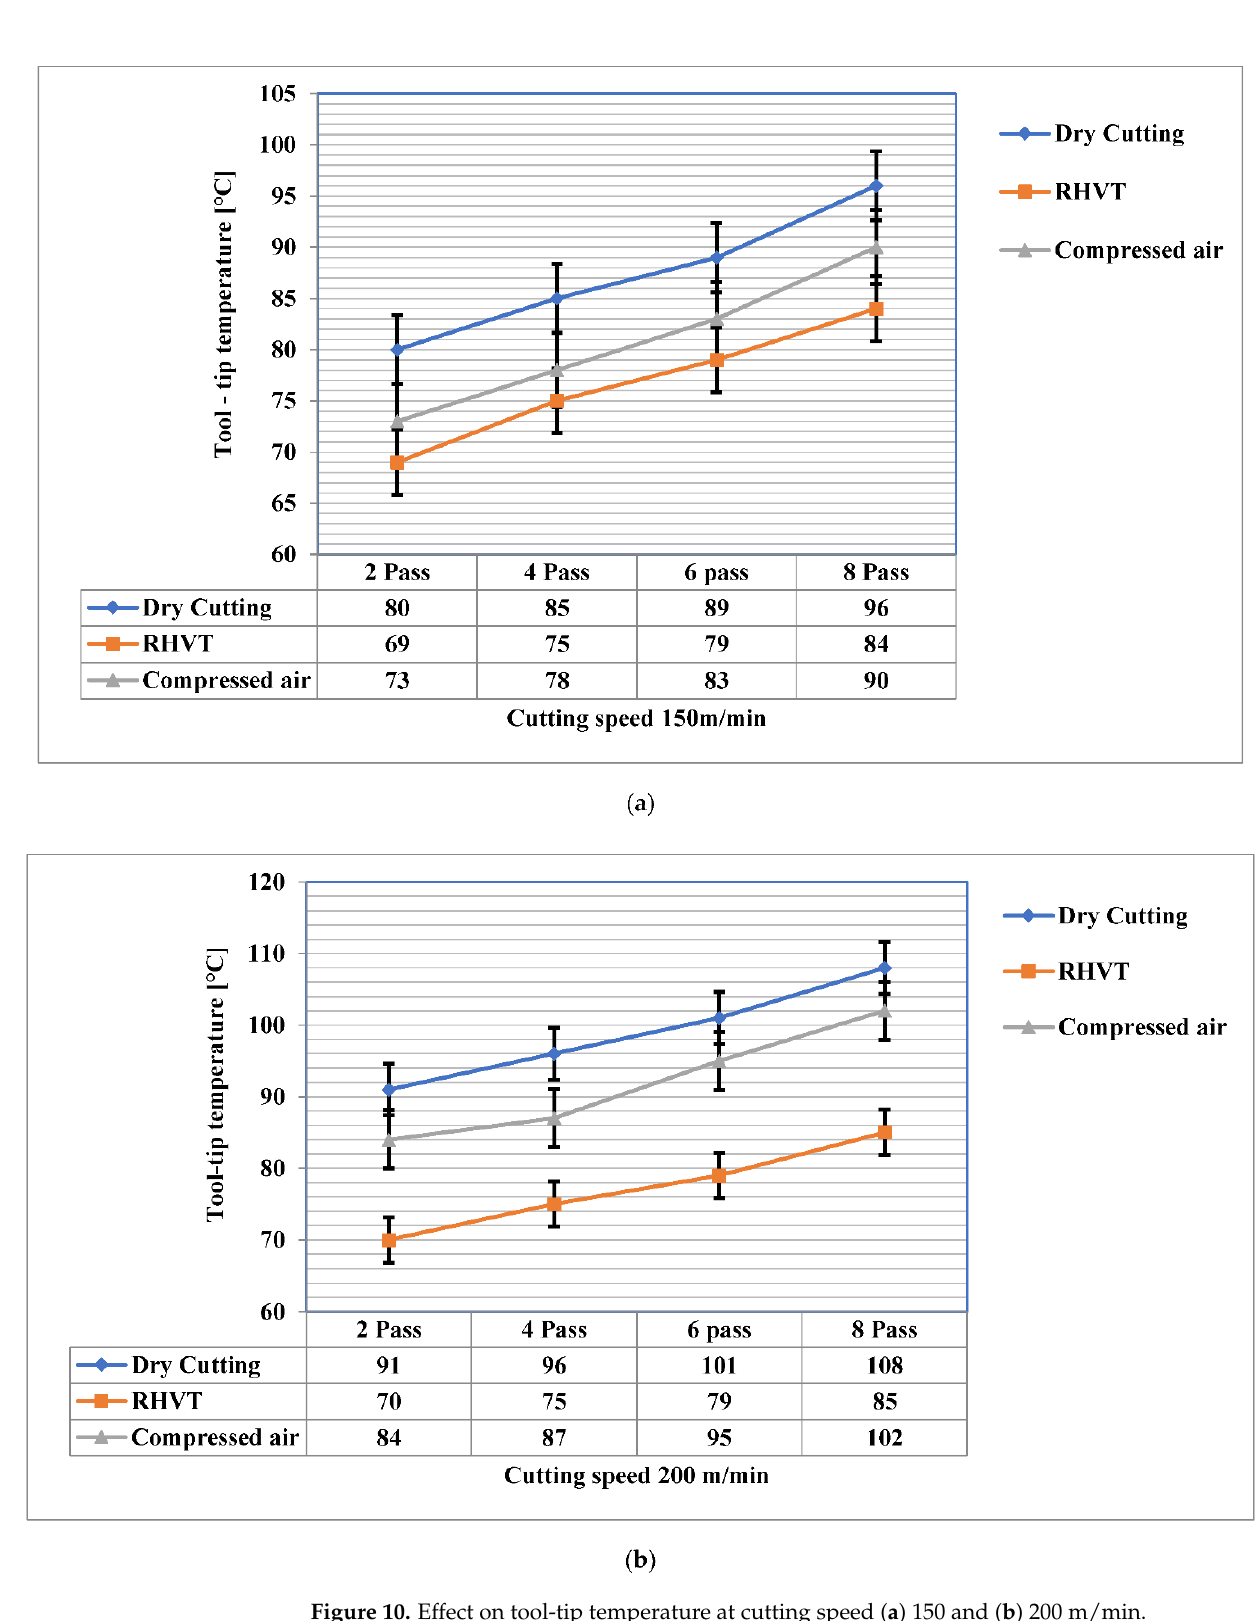
Figure 10. Effect on tool-tip temperature at cutting speed ( a ) 150 and ( b ) 200